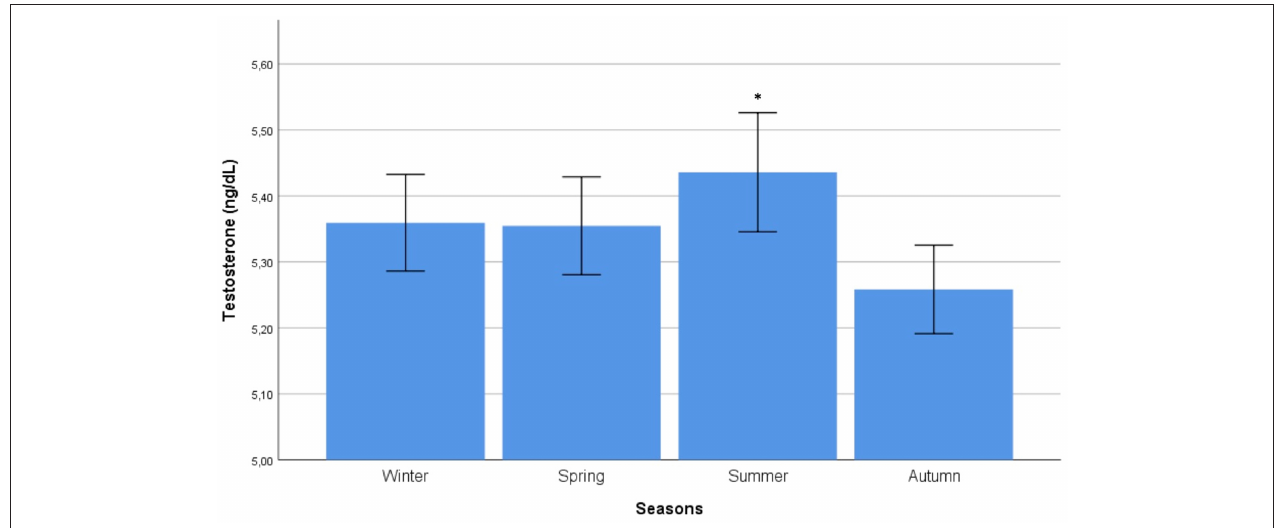
FIGURE 2 | Comparison of mean testosterone serum levels among seasons. Comparison was performed by Kruskal-Wallis test. *Identifies the highest testosterone serum levels at post hoc Tukey test.